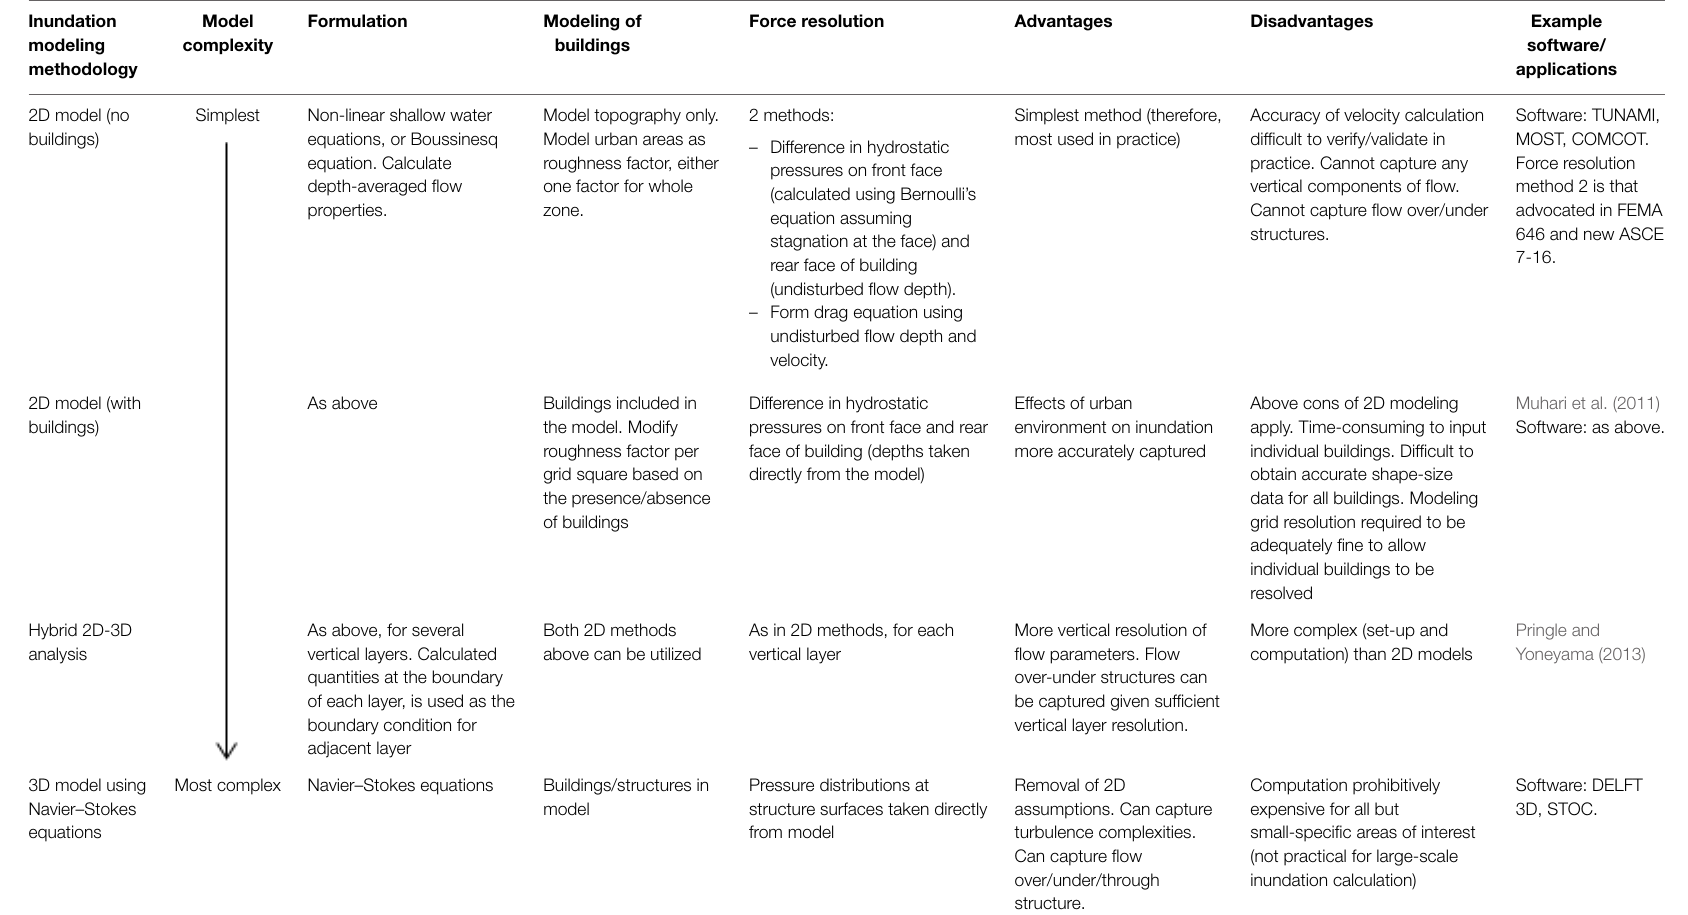
TABLE 8 | A summary of numerical methods that have been used to define tsunami-induced forces on